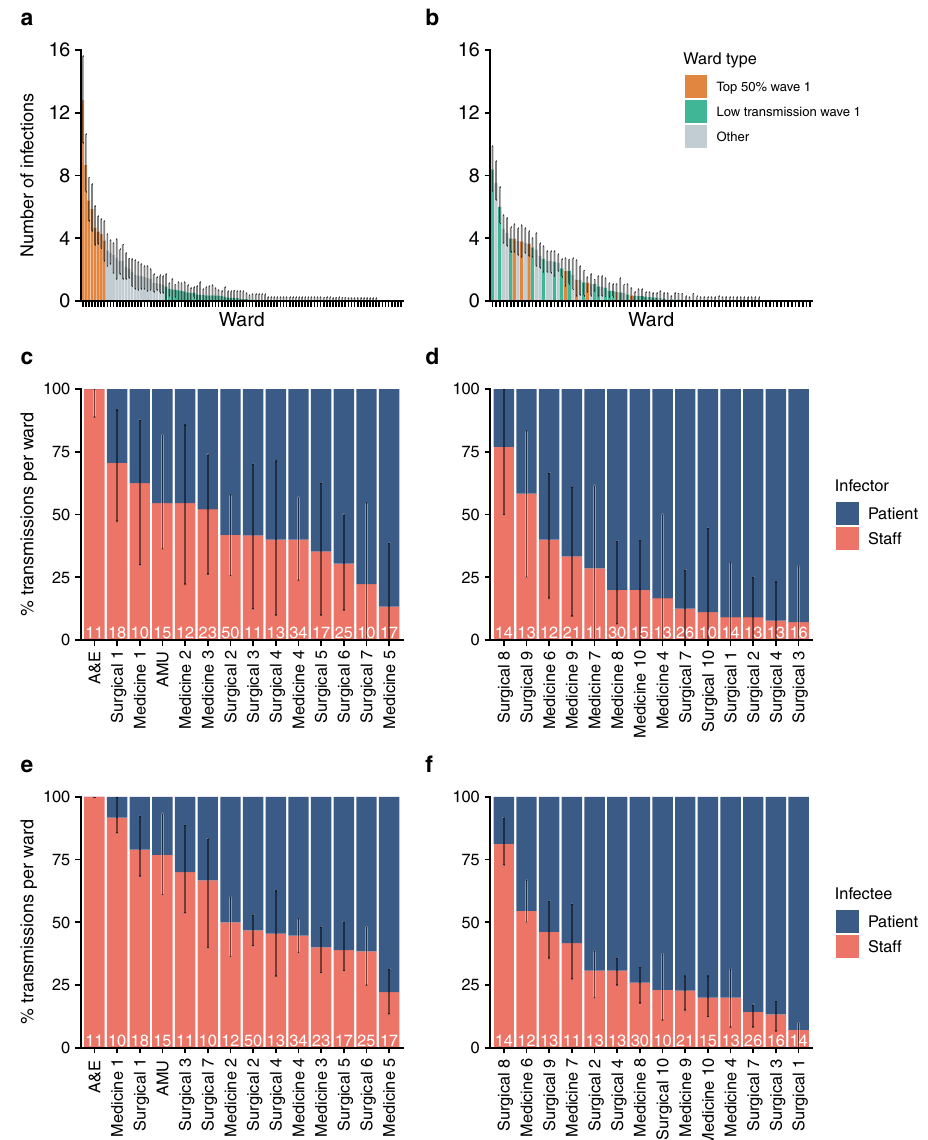
Fig. 3 Hospital locations contributing to transmission events. a The number of infections per ward in Wave 1. b The number of infections per each ward in Wave 2. Wards contributing to 50% of all transmission events in Wave 1 ( n = 8) are coloured in orange in both Wave 1 and Wave 2 datasets. Wards with <1 transmission (mean of 10,000 networks) in Wave 1 are coloured in green in both Wave 1 and Wave 2 datasets. c – f Percentage of staff and patient infector and infectees per ward involved in transmission events. All wards with 10 or more transmissions in Wave 1 and Wave 2 are shown. Wards are ordered by the percentage of staff infector cases in Wave 1 c and Wave 2 d and percentage of staff infectee cases in Wave 1 e and Wave 2 f . Numbers of transmission events per ward are shown at the bottom of each column. The percentage of staff-staff transmissions in A&E is arti fi cially high (100%) due to the inability to obtain patient movement data in this location. Error bars represent 95% credible intervals. A&E accident and emergency department; AMU acute medical